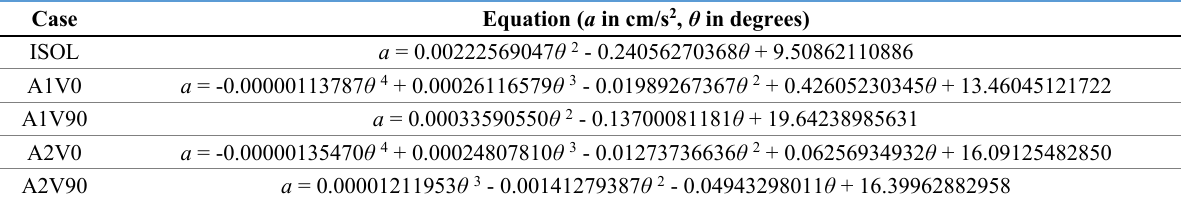
Table 7. Equations for maximum acceleration at the top, y-direction.